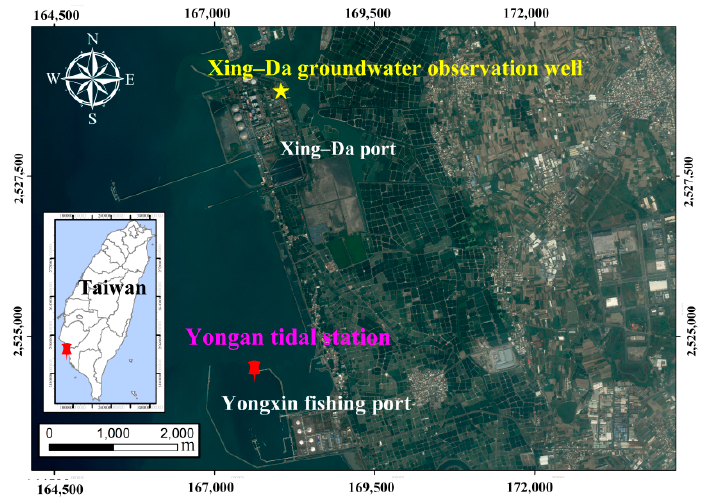
Figure 15. The location of Xing–Da port in southwestern Taiwan.